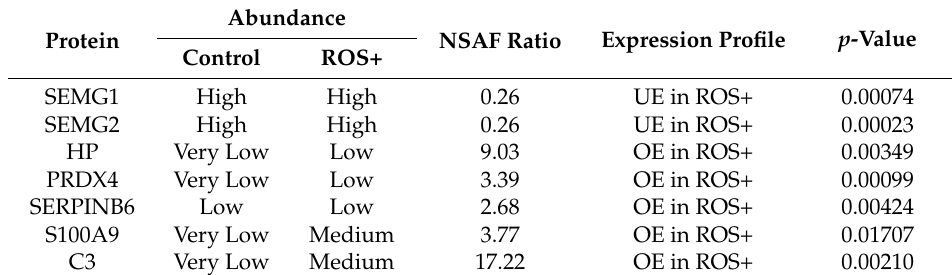
Table 2. Proteomic data of the differentially expressed proteins identified in seminal plasma samples from fertile donors from control and ROS+ groups, selected for validation by Western blot.